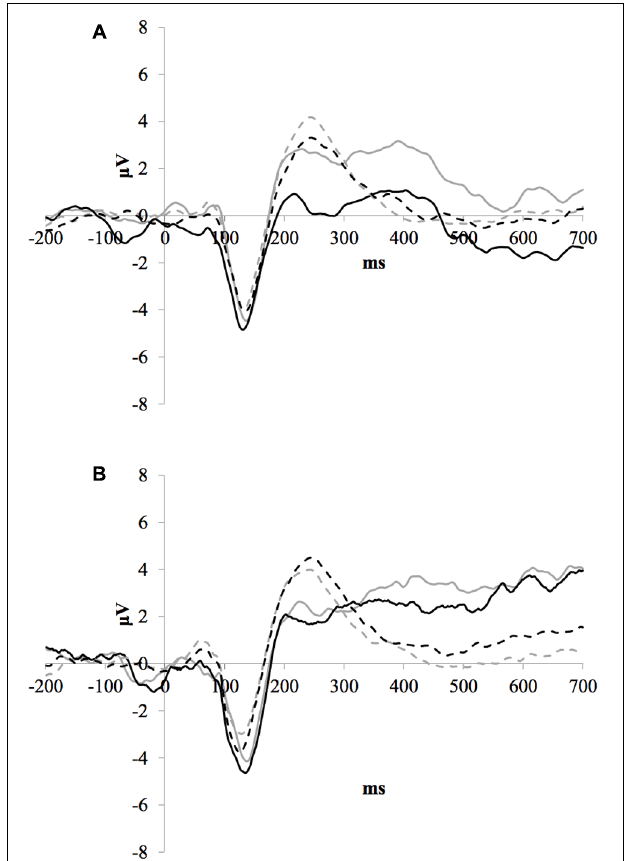
FIGURE 2 | (A) Grand average ERP waveforms of the oddball (solid line) and frequent (dotted line) stimuli for the trained group at baseline (gray line) and post-test (black line) at electrode FCz. (B) Grand average ERP waveforms of the oddball (solid line) and frequent (dotted line) stimuli for the control group at baseline (gray line) and post-test (black line) at electrode